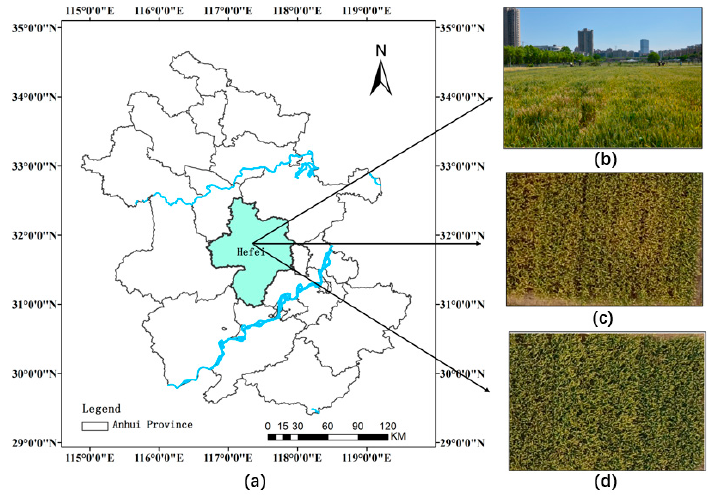
Figure 1. Experimental field. ( a ) Experimental site; ( b ) fieldwork situation; ( c ) vaccinated experimental area; ( d ) unvaccinated experimental area.